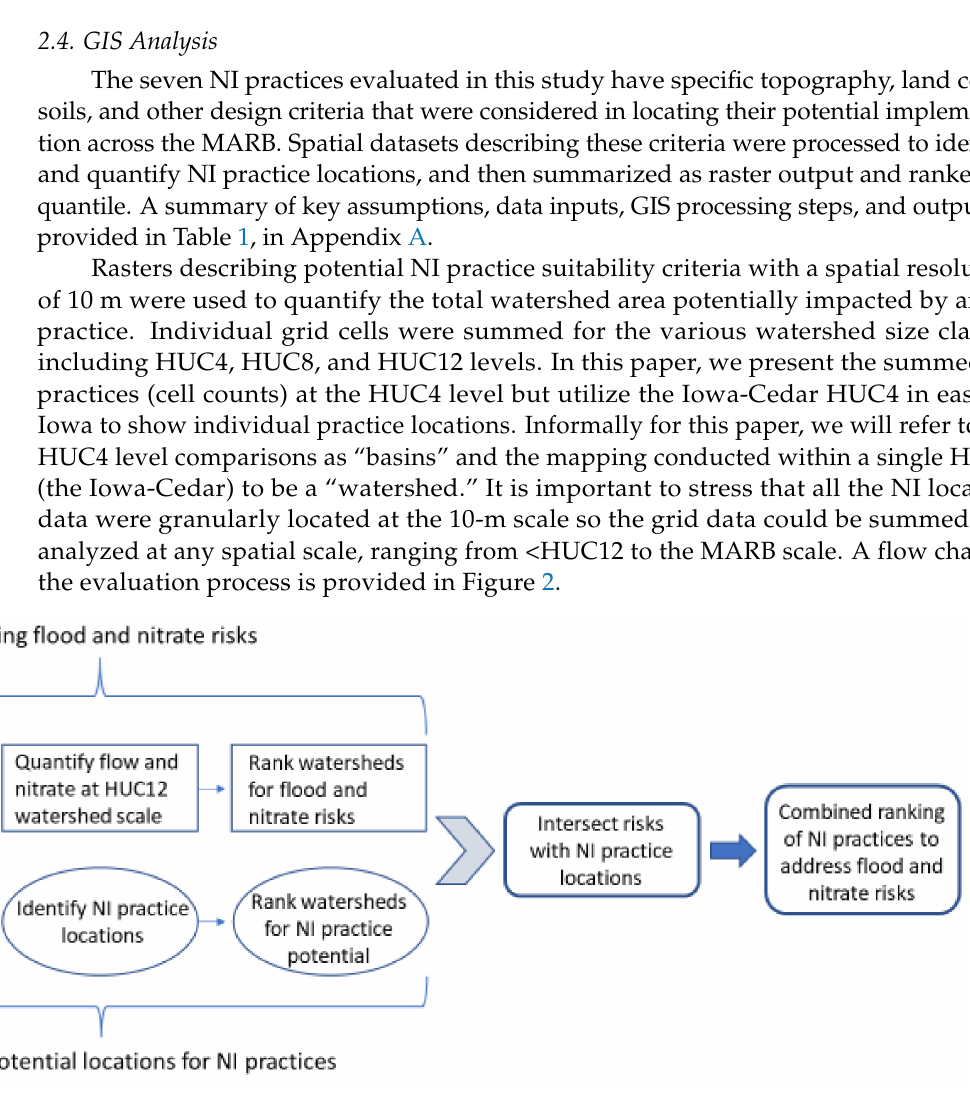
Figure 2. Flow chart of evaluation process whereby ranks of watersheds with flood and nitrate risks are combined with ranks of watersheds with NI practice potential to derive a combined ranking of watersheds where NI practices can do the most good to reduce flood and nitrate